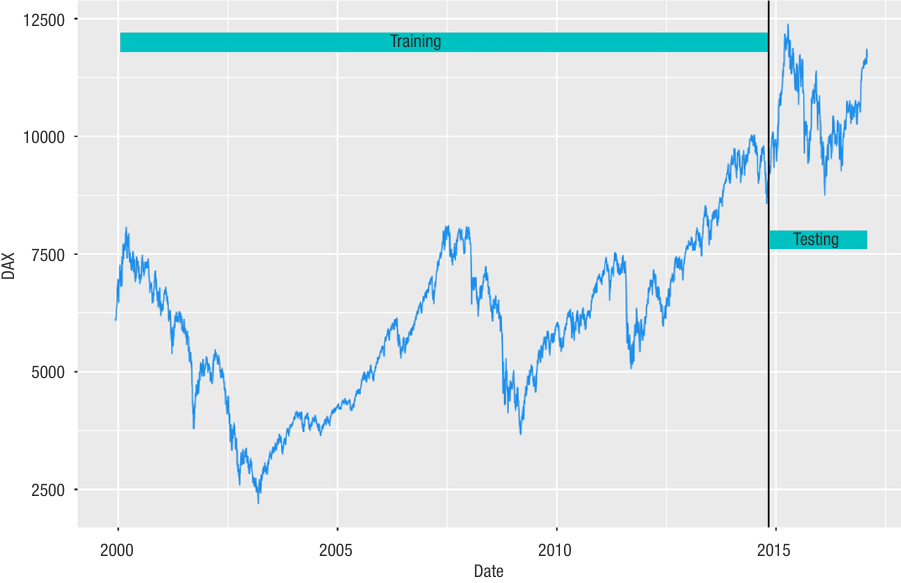
Figure 2. German DAX-30 performance during the period analysed (8th December 1999 to 30th January